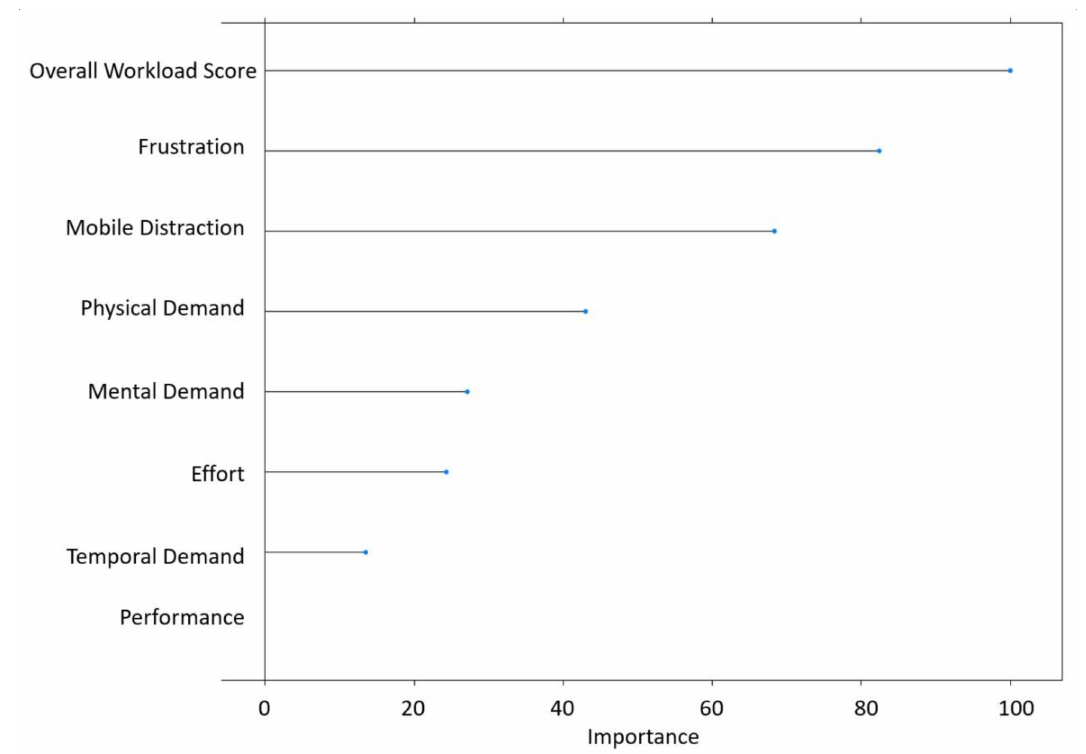
Figure 7. Importance graph related to crossing over the hard shoulder line violations. Table 6. Summary of violations in which the importance of the Overall Workload Score and mobile phone distractions is among the three more